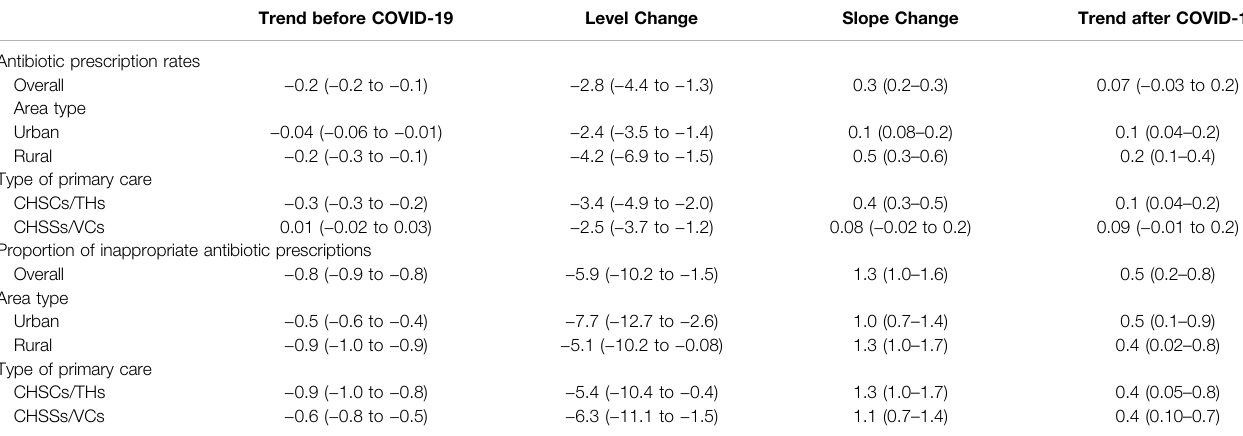
TABLE 3 | Trends of and impact of COVID-19 on the antibiotic prescriptions in primary care settings in Yinchuan City. Trend before COVID-19 Level Change Slope Change Trend after COVID-19 Antibiotic prescription rates Overall − 0.2 ( − 0.2 to −